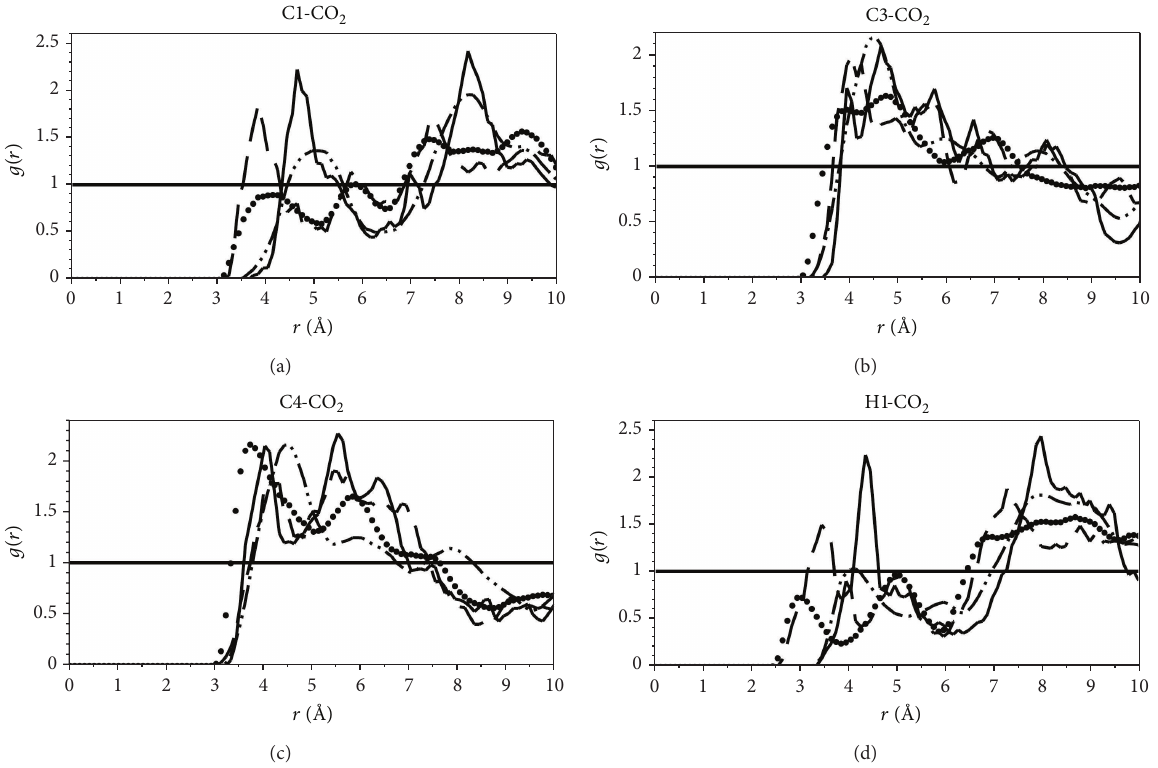
(--), and Δ𝐸 (– ∘ –) energies of some CO 2 –[C 7 H 5 N 2 ] − complexes. AMBER SAMBER